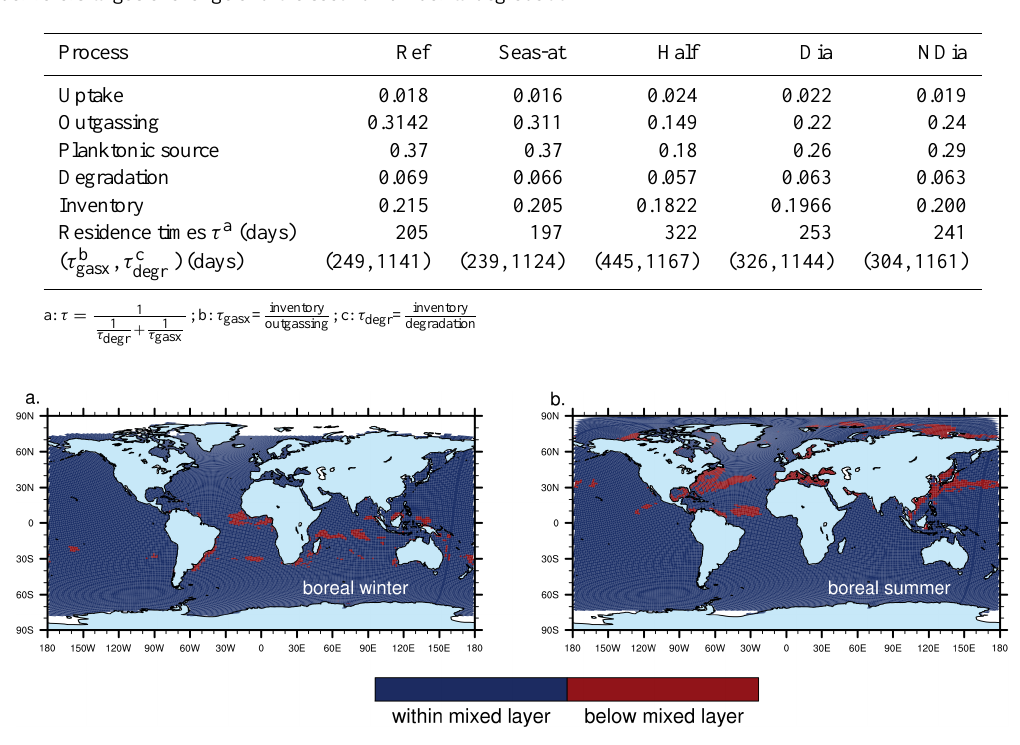
Figure 3. Location of bromoform production maxima in Ref: within or below mixed layer for boreal winter (a) and boreal summer (b) . The mixed-layer depth is defined as the depth where a density ( σ T ) difference of 0.125 relative to the surface value